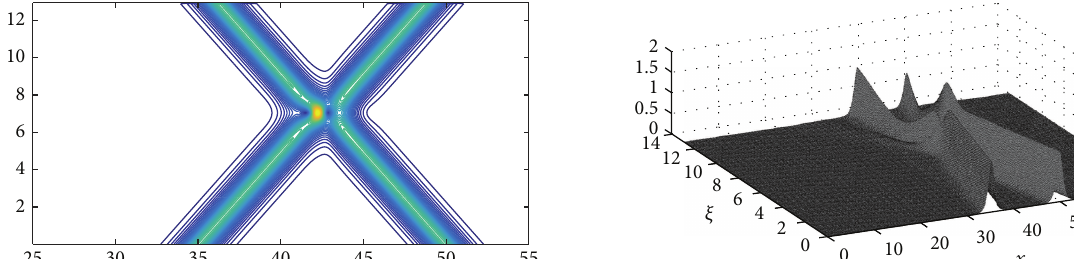
Figure 15: Collision of coupled-mode solitons with 𝜙 1 = 𝜋 and 𝜙 2 = 0 .